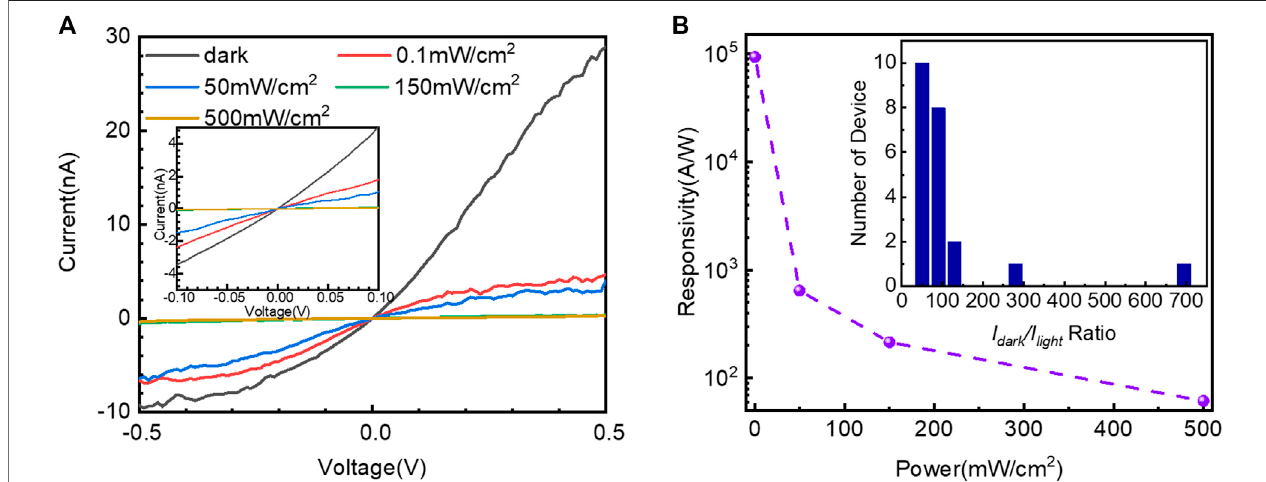
FIGURE3|(A) I – VcharacteristicsoftheInAsNWphotodetectorunderthe405 nmlaserincidenceat0.1,50,150,and500 mW/cm 2 .Theinsetshowsthezoom-in I – Vcurvesweptfrom − 0.1to0.1 V. (B) Responsivityasafunctionoftheincidentilluminationintensity.Theinsetshowsthehistogramofthemaximum I dark /I light ratioof22 InAs NW photodetectors.